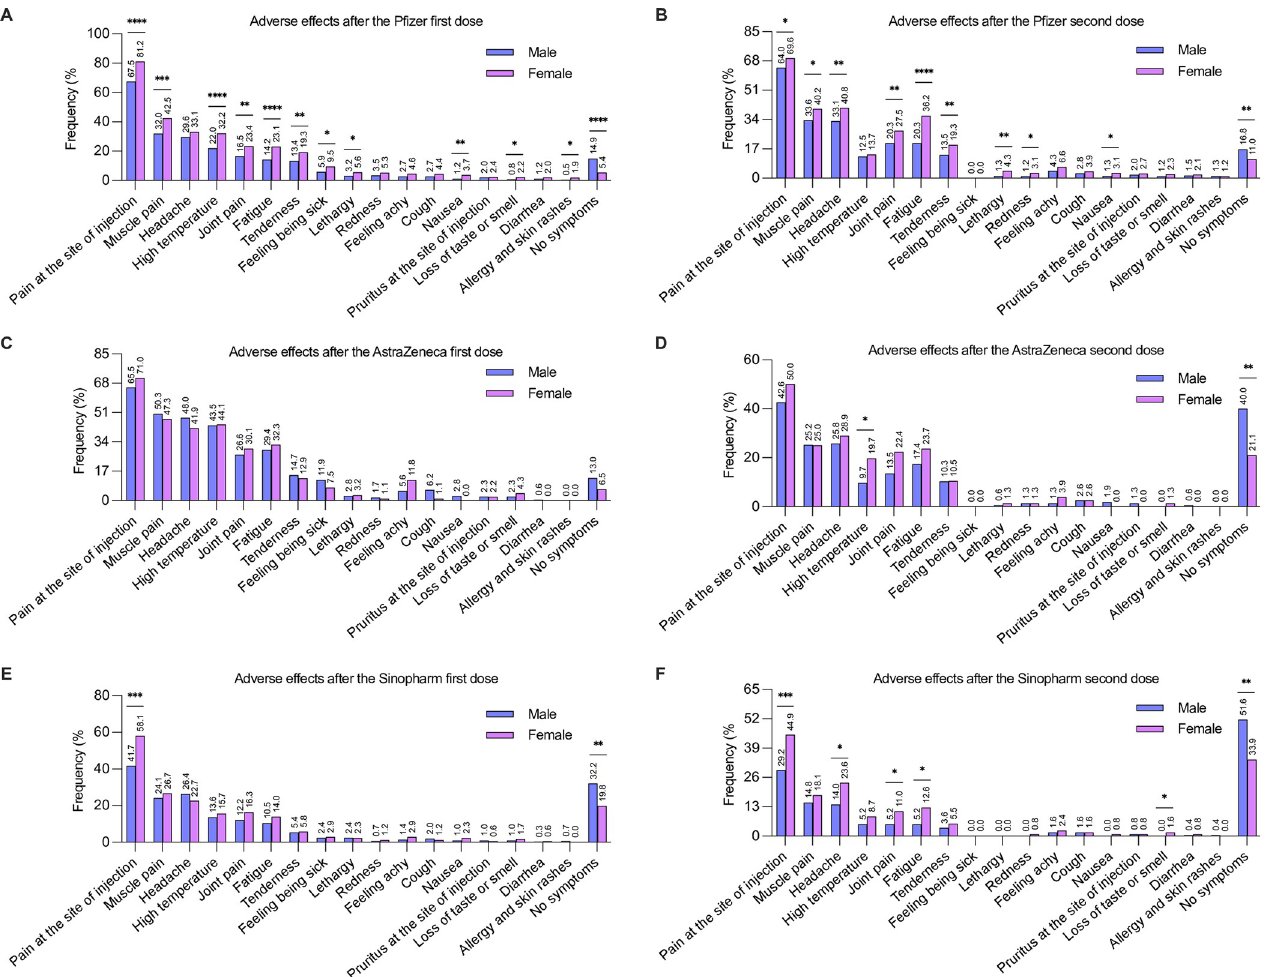
Fig 3. Prevalence of the adverse effects (percentage) associated with various vaccine types among vaccinated male and female participants. (A) Pfizer after the first dose, (B) Pfizer after the second dose, (C) AstraZeneca after the first dose, (D) AstraZeneca after the second dose, (E) Sinopharm after the first dose, (F) Sinopharm after the second dose. Statistical analysis of the adverse effects associated with various vaccine types (males versus females) was performed using the chi-squared test. � p < 0.05, �� p < 0.01, ��� p < 0.001 and ���� p < 0.0001.